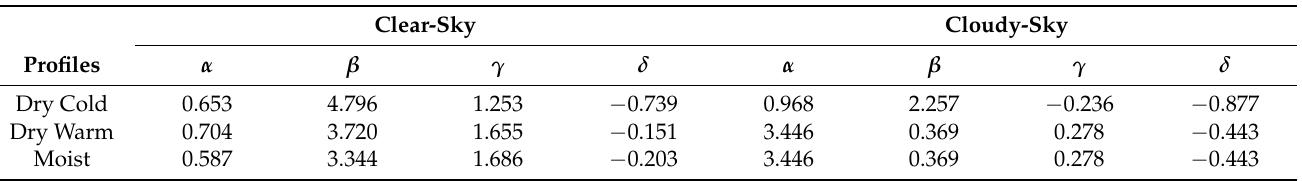
Table A1. Calibrated parameters for the LSA_OPER model [14], i.e., the LSA-SAF operational algorithm that makes use of TIGR-like database (1992–1993) [38] for different atmospheric profiles under clear and cloudy-sky.